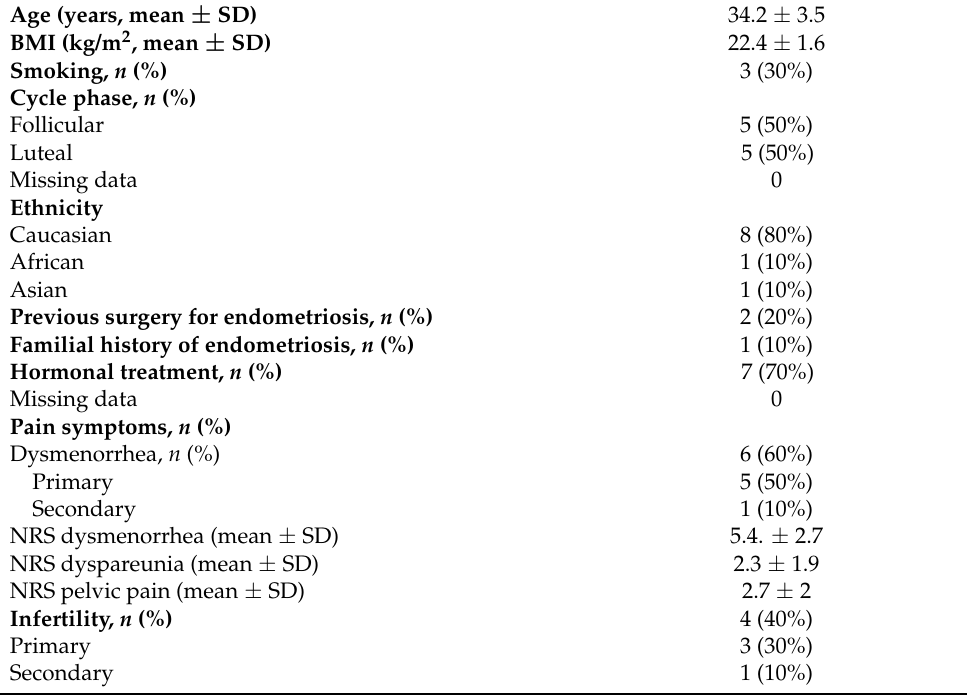
Table 3. Clinical characteristics of the study population selected for transfection experiments: n = 10 patients with endometriosis:(OMA). NRS: Numerical Rating Scale. BMI: body mass index. SD: standard